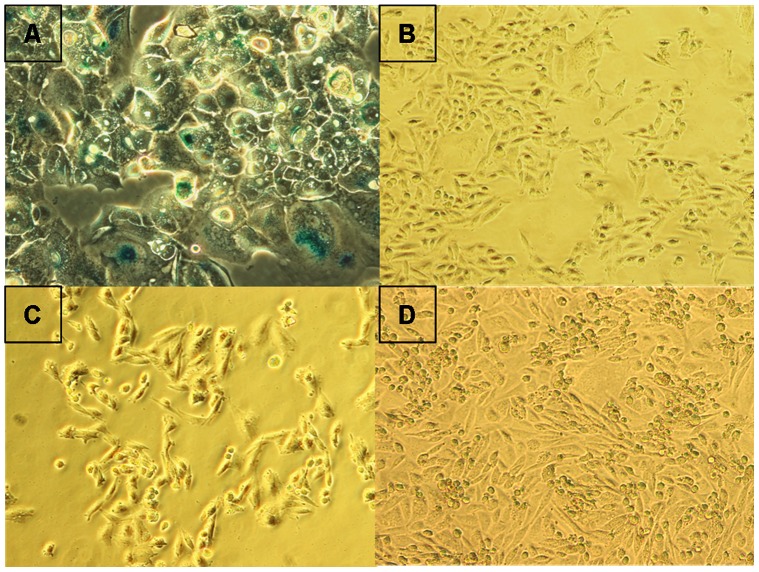
MiR-7 does not induce senescence.β-galactosidase activity was assayed after 96 hrs in cells treated with BrdU or transfected with pm-neg or pm-7. A: HCC1419 cells treated with 50 µM BrdU as positive control for senescence; B: pm-neg-treated CHO cells; C: pm-7-treated cells; D: CHO cells treated with 500 µM BrdU.